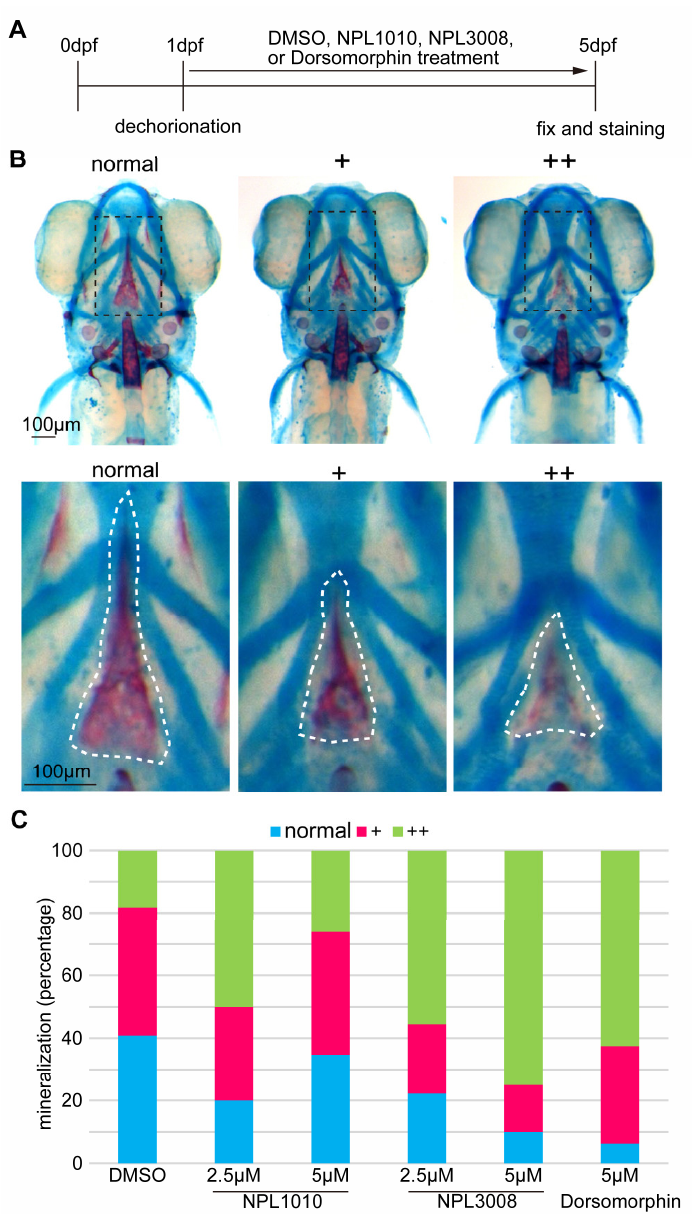
Figure 3. NPL1010 and NPL3008 inhibit bone formation in vivo. ( A ) Schematic diagram of the analysis of the effects of NPL1010 and NPL3008 on bone formation in zebrafish embryos. ( B ) Images of Alizarin red and Alcian blue staining and classification of bone mineralization: normal, slight reduction/mild phenotype (+), and strong reduction/severe phenotype (++). Dorsal views of the head, anterior to the top (upper panels). Red staining shows mineralized bone, and blue staining shows cartilage. The black dotted boxed region indicates the parasphenoid bone region. Scale bar, 100 µ m. Enlarged views of the boxed area in the upper panels are shown in the bottom panels. The white dotted lines indicate mineralized parasphenoid bone. Scale bar, 100 µ m. ( C ) Proportion of zebrafish displaying phenotypes after treatment with NPL1010, NPL3008, and dorsomorphin (each category corresponds to ( B )) ( n = 9–23).